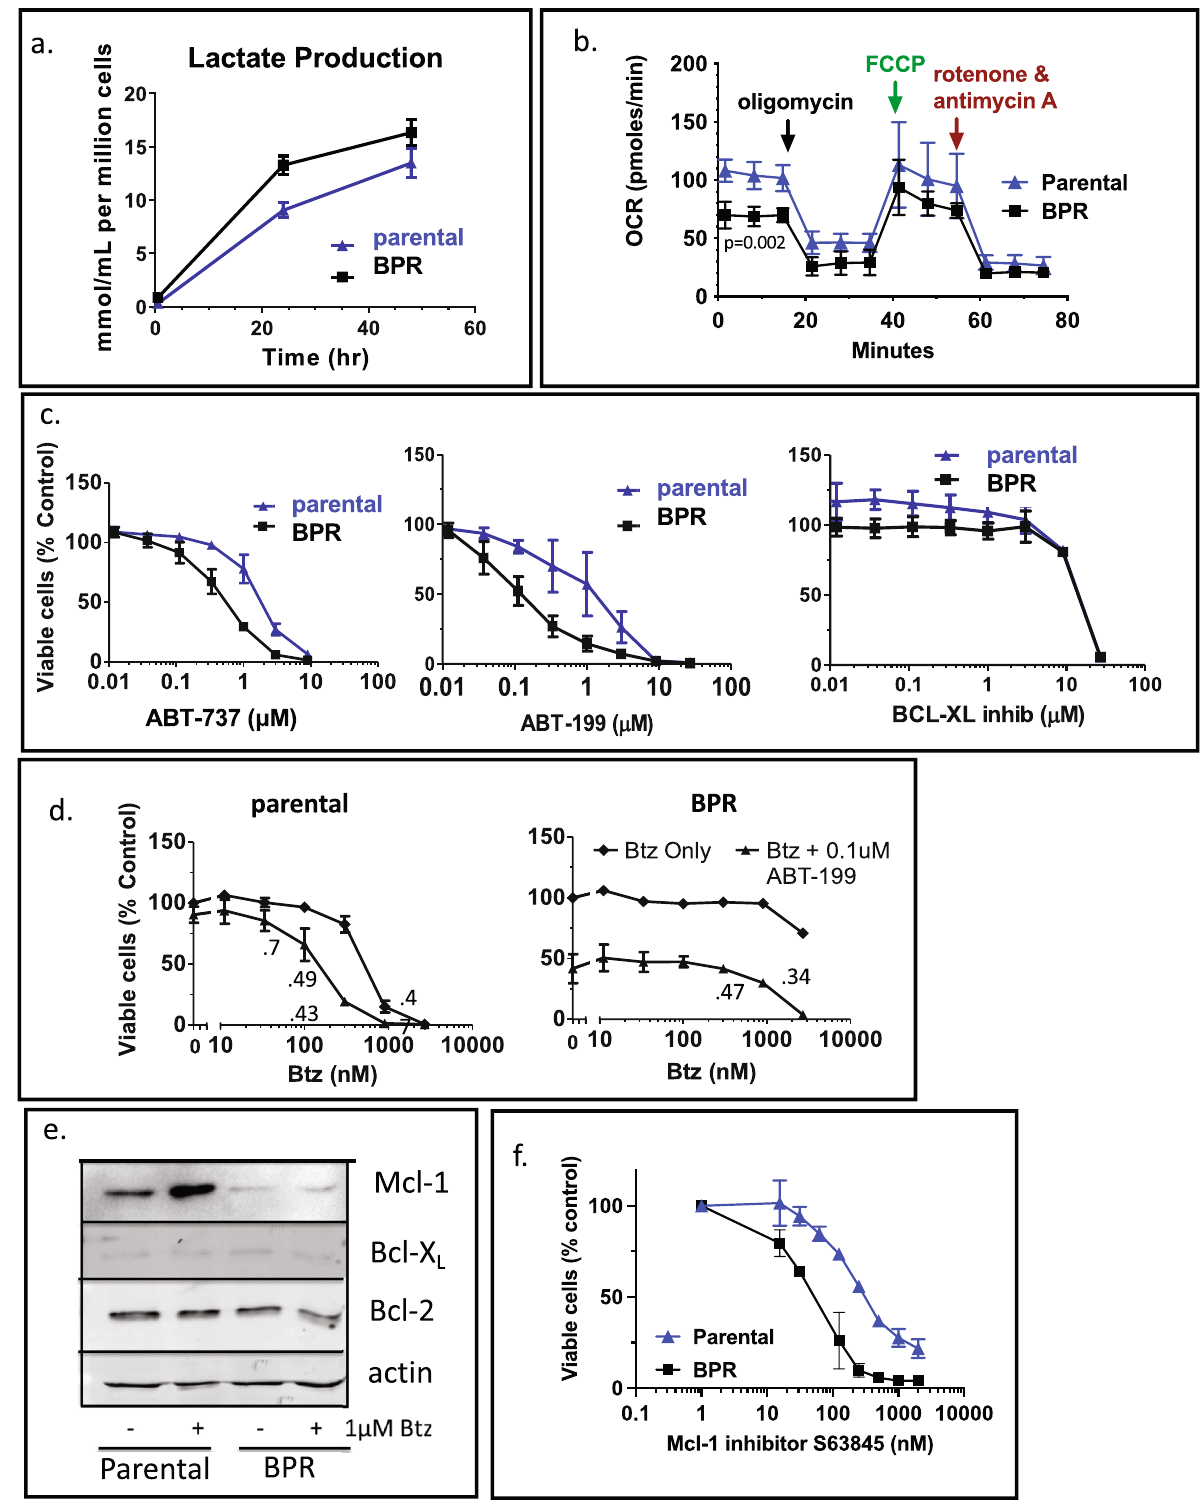
Figure 4. KMS-12-BM-PPR are more sensitive to BCL-2 inhibition than the parental cells. ( a ) Lactate production was measured over time and normalized for cell count. ( b ) Oxygen consumption rate was measured before and after exposure to the inhibitors of the electron transport chain and oxidative phosphorylation. ( c ) Cells were treated continuously for 48 h with ABT-737 before being assayed for viability with Alamar Blue (n = 2). ( c ) BPR cells are more sensitive to a Bcl-2-specific inhibitor ABT-199, but not Bcl-X L specific inhibitor. Left, cells were treated for 48 h with ABT-199 (left) or Bcl-X L inhibitor (A-1155463) before viability was determined by Alamar Blue (n = 2–3). ( d ) Cells were treated with Btz for 1 h and then with ABT-199 for 47 h before viability was determined by Alamar Blue (n = 2–4). The numbers on the graph are combination indexes (CI). ( e ) Expression of Bcl-2 family member proteins was determined by westerns following 1 h pulse treatment with Btz and overnight recovery. Uncropped images are presented on Fig. S3c. ( f ) Cells were treated for 48 h with Mcl-1 inhibitor S63845 before viability was determined by Alamar Blue (n =